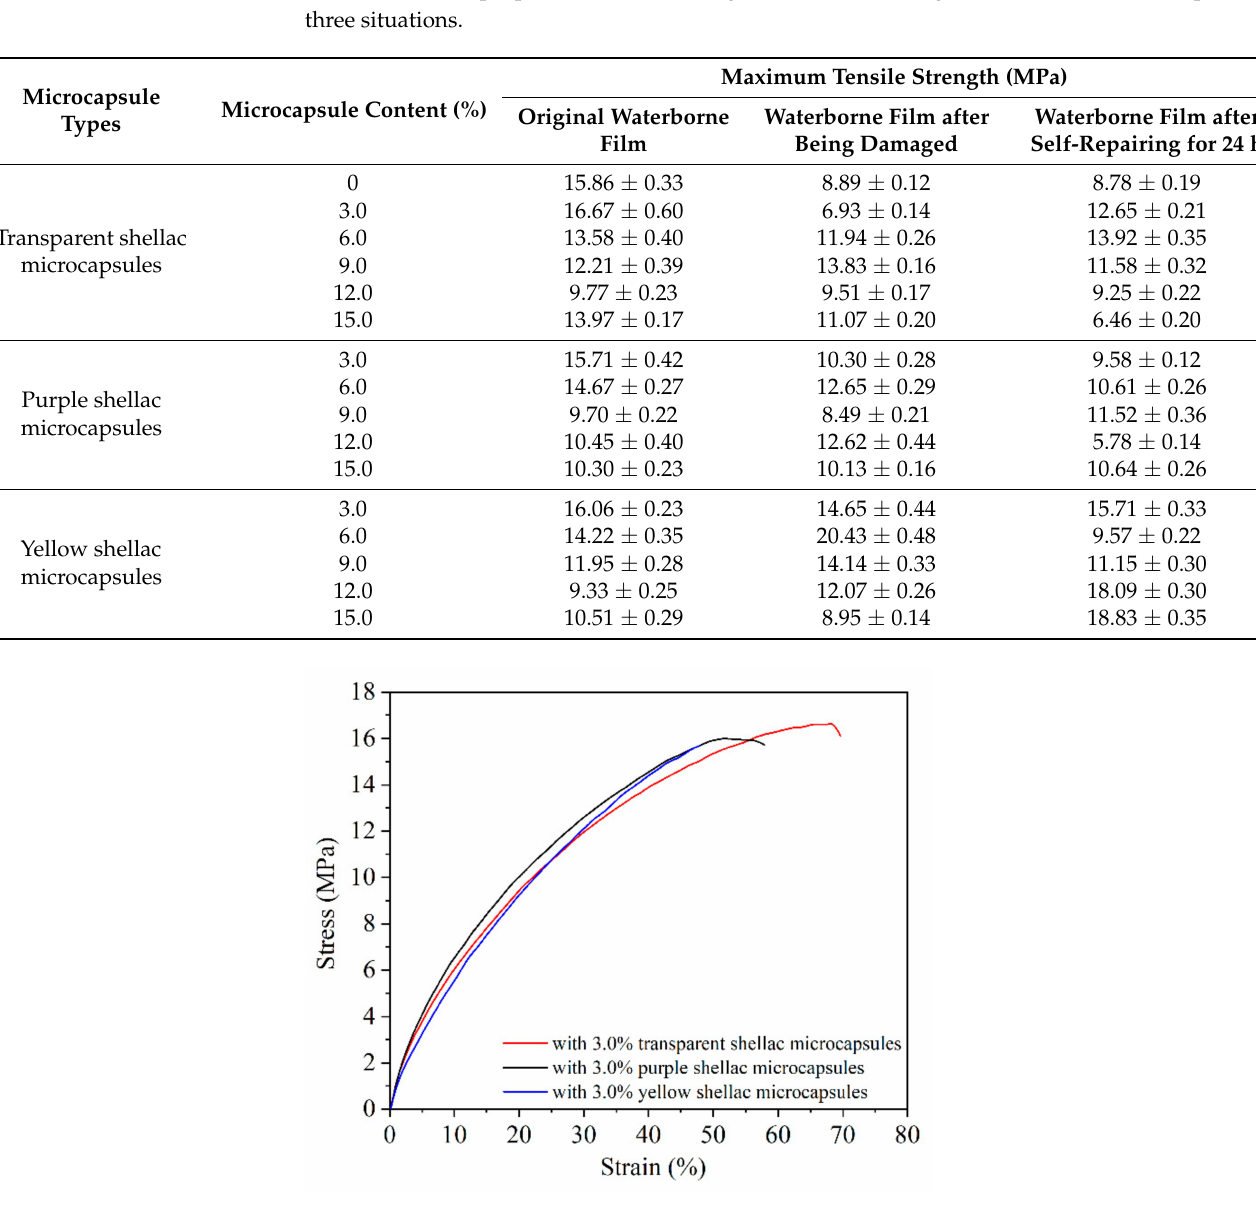
Figure 8. Stress–strain curves of microcapsule coatings with different shellac core